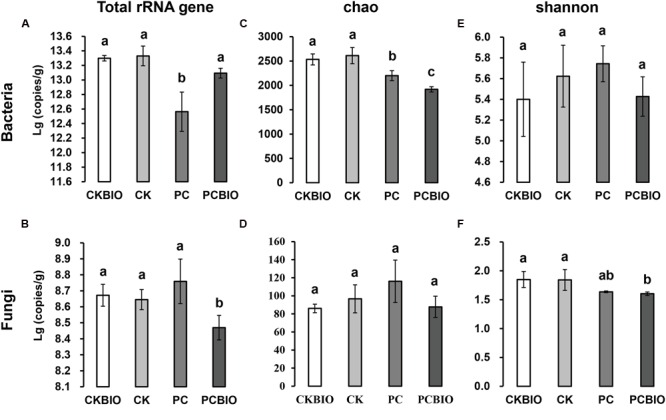
Microbial population and community richness and diversity for different treatments and control. Bars with different letters indicate significant differences among the four treatments, as defined by Duncan’s test (P < 0.05). (A) Total number of bacteria quantified by qPCR; (B) total number of fungi quantified by qPCR; (C) bacterial Chao index; (D) fungal Chao index; (E): bacterial Shannon index; (F): fungal Shannon index. CK: the mature chicken manure compost; CKBIO: the mature chicken manure compost with strain SQR9 inoculation; PC: pre-compost of mixture piles of mature chicken manure and CLAA; PCBIO: inoculation of strain SQR9 in mixture piles of mature chicken manure and CLAA after pre-compost.